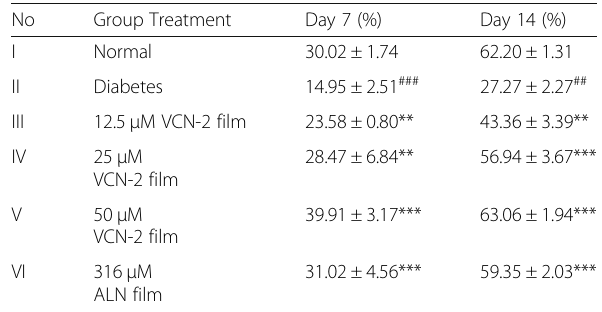
Table 4 Percentage of the wound contraction in rats with post infliction of excised wound after treatment for 14 day No Group